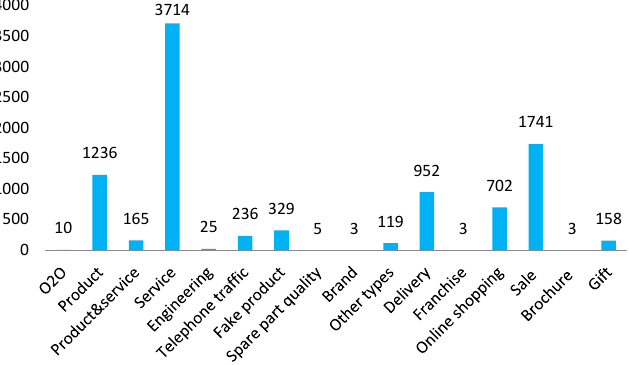
Figure 5. Number of cases with different complaint problems.